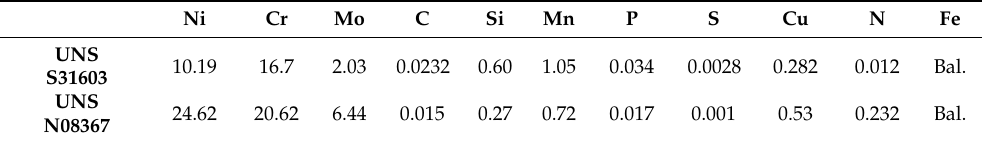
Table 1. Chemical compositions of UNS S31603 and UNS N08367 (wt. %).